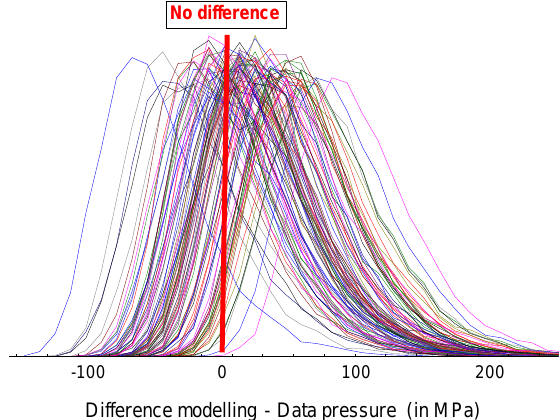
Figure 8. The 90% confidence intervals of modeled data by the Lambda distribution for the maximal pressure versus the values predicted by the local contact model.